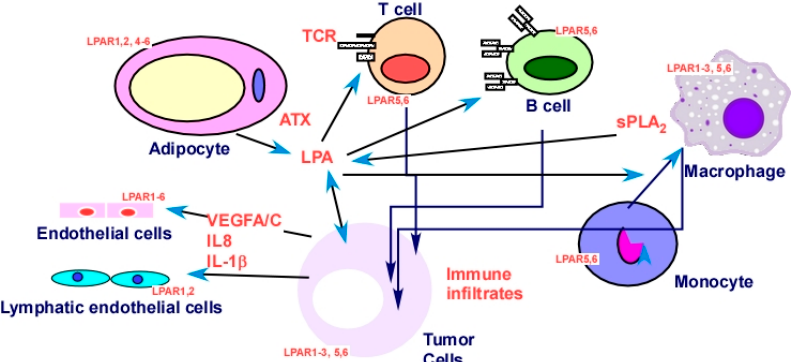
Figure 5. LPA in tumor cells and in the tumor microenvironment (TME). Tumor, stromal, and immune cells in the TME express LPA receptors, and they produce and/or respond to LPA [34,119,185,202,247,256,289–294] . The overall effects produce a tumor-promoting environment as detailed in Section 2.2.5 and in recent reviews [7,21,135]